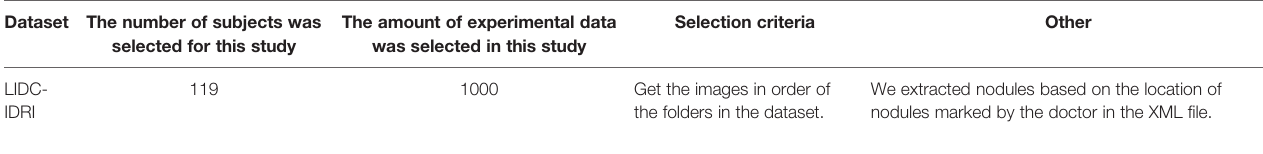
TABLE 1 | Summary of dataset. Dataset The number of subjects was selected for this study